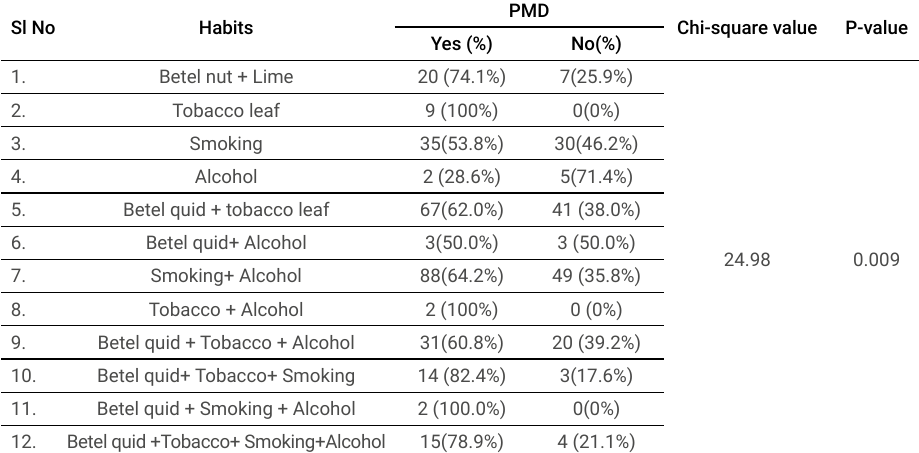
Table 2. Distribution of subjects according to Habits and